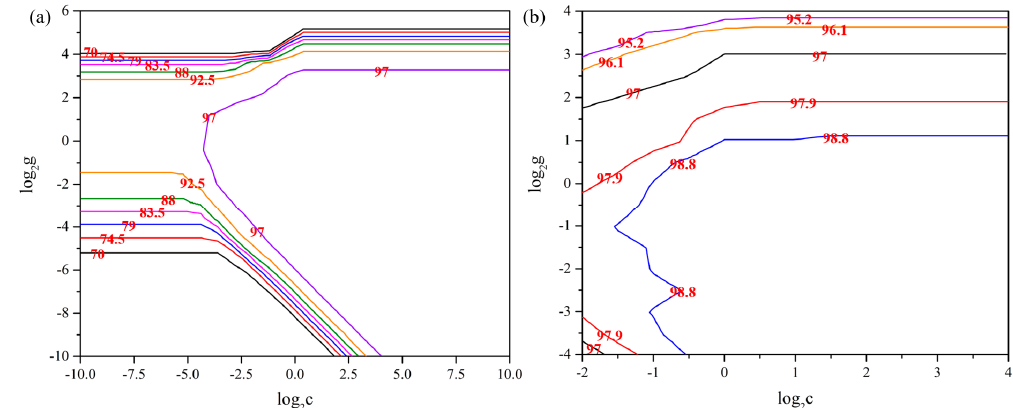
Figure 6. ( a ) Large − scale grid search results. ( b ) Small − scale grid search results.